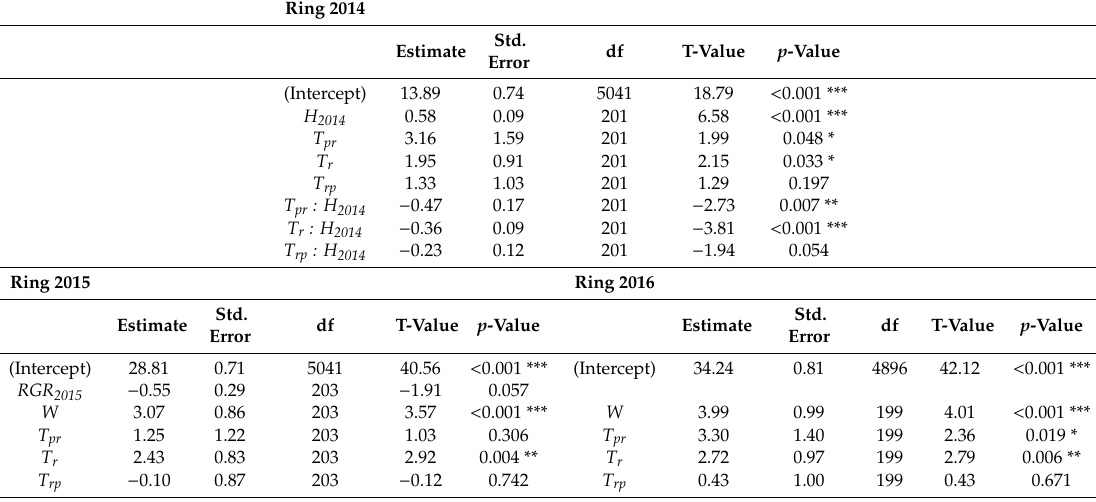
Table 3. Model statistics for the response variable latewood vessel diameter. The standard level of the categorical variable taxon of the mother tree ( T ) was Q. petraea , to which the other taxa were compared with. T pr : long stalked intermediate form, T r : Q. robur , T rp : short-stalked intermediate form. H 2014 : height at the end of the first growing season. RGR 2015 and RGR 2016 : relative growth rates in height for 2015 and 2016, respectively. W : adjusted relative extractable water in 2014.